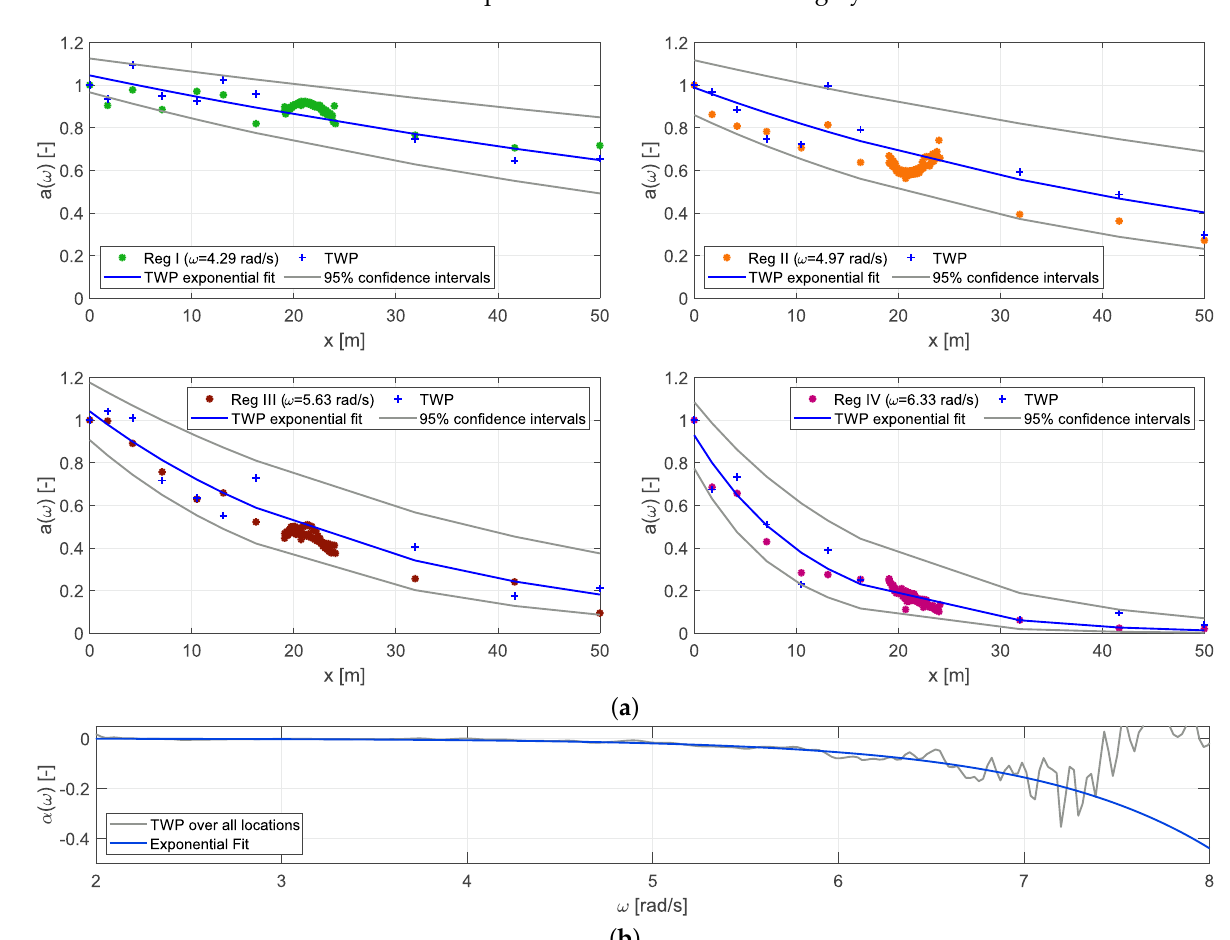
Figure 5. Presentation of the experimentally determined attenuation and damping coefficients. The attenuation coefficient for four selected frequencies is shown in ( a ), comparing the results of regular waves with the TWP measurements of the same frequency. The exponential damping coefficient determined by the TWP technique is presented in ( b ). ( a ) Comparison of the attenuation coefficients for selected frequencies of the TPW (plus) and the corresponding four investigated regular waves (stars). ( b ) Frequency-dependent exponential damping coefficient